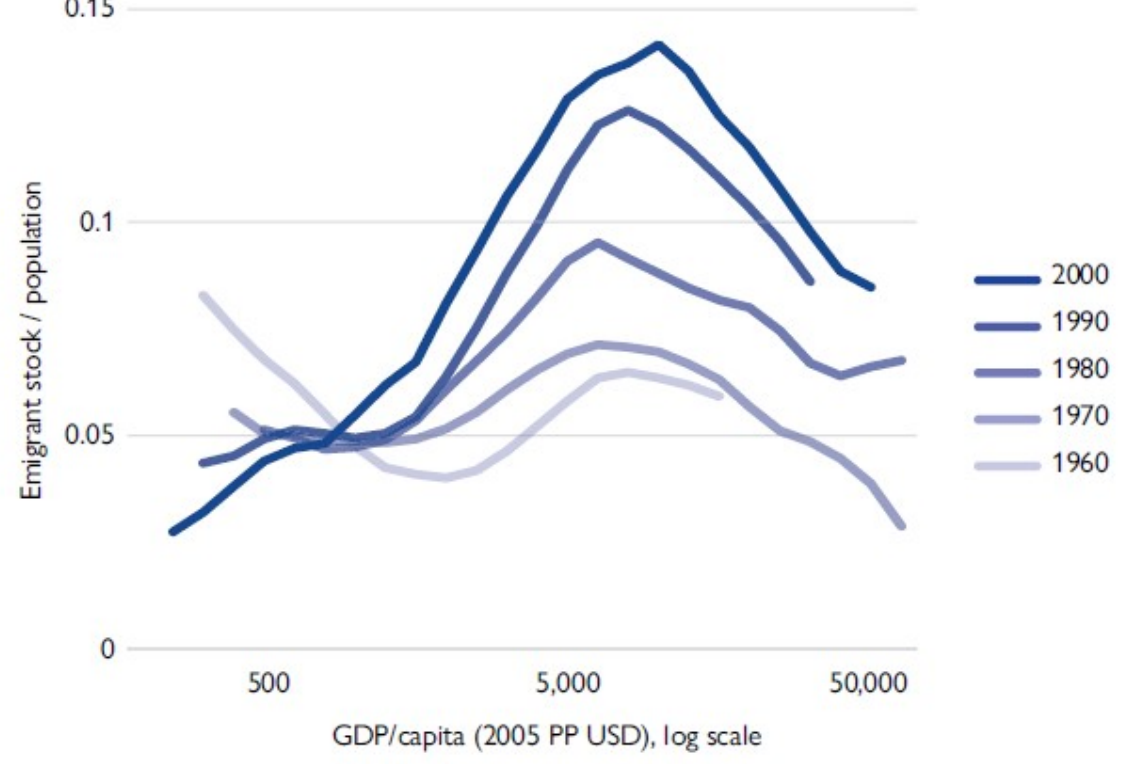
Figure 1. The migration hump. Adapted from Clemens